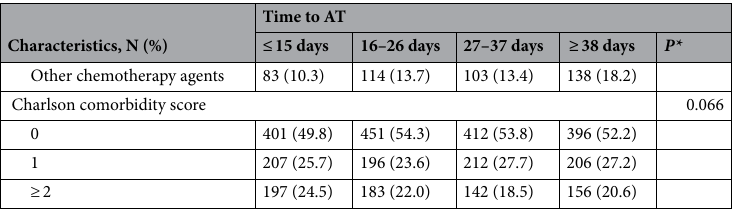
(Table 4) and in the PSM-matched sub-cohort (Table S9). After performing the PSM method, the sample size of matched sub-cohort by early-timing versus delayed-timing was 4776 from the NCDB.